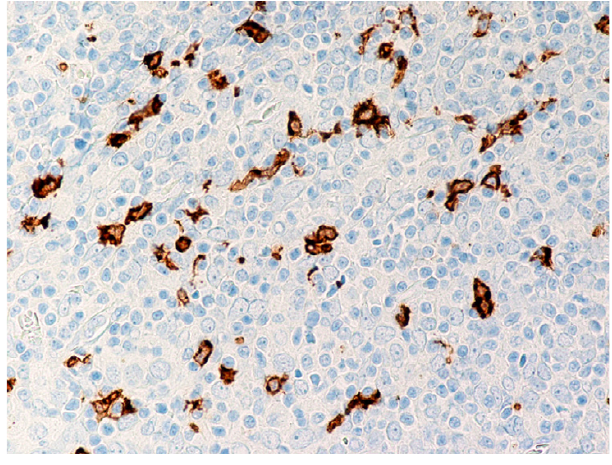
Figure 11 (B-SA, anti-CD57, × 400): Type B3 thymoma not associated with autoimmune disease. Single neoplastic epithelial cells express CD57.